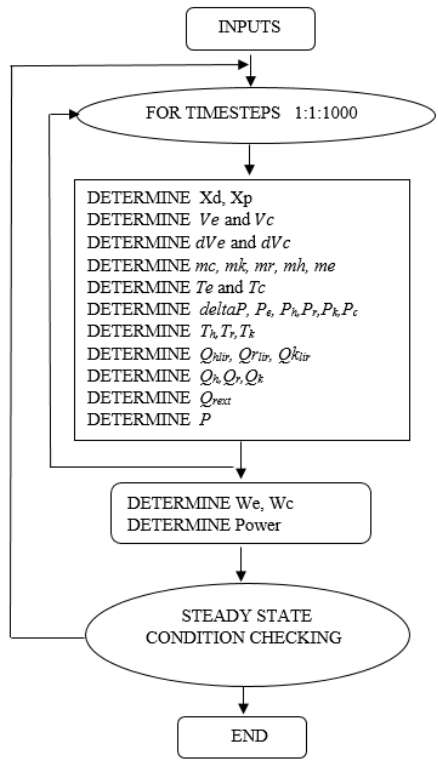
Figure 3. Flow chart of the quasi-steady state modelling of the free piston Stirling engine. Table 3. Design parameters of the heat exchangers.